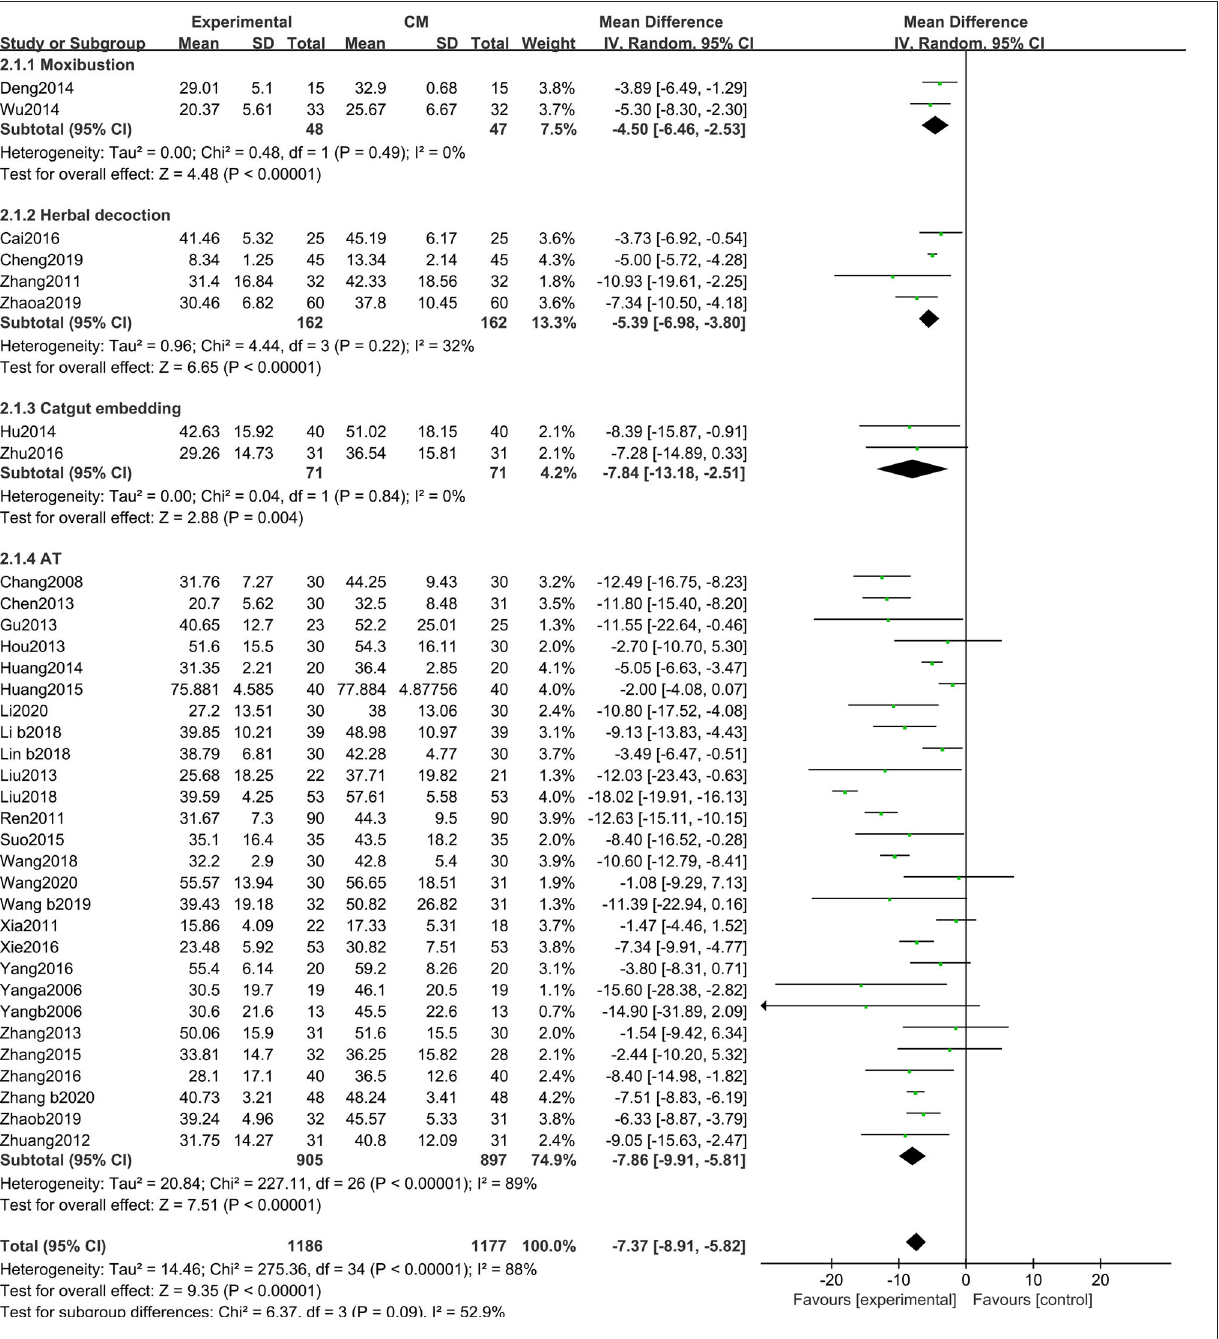
FIGURE 4 | Comparison of acupuncture related therapies in terms of UPDRS-Total.